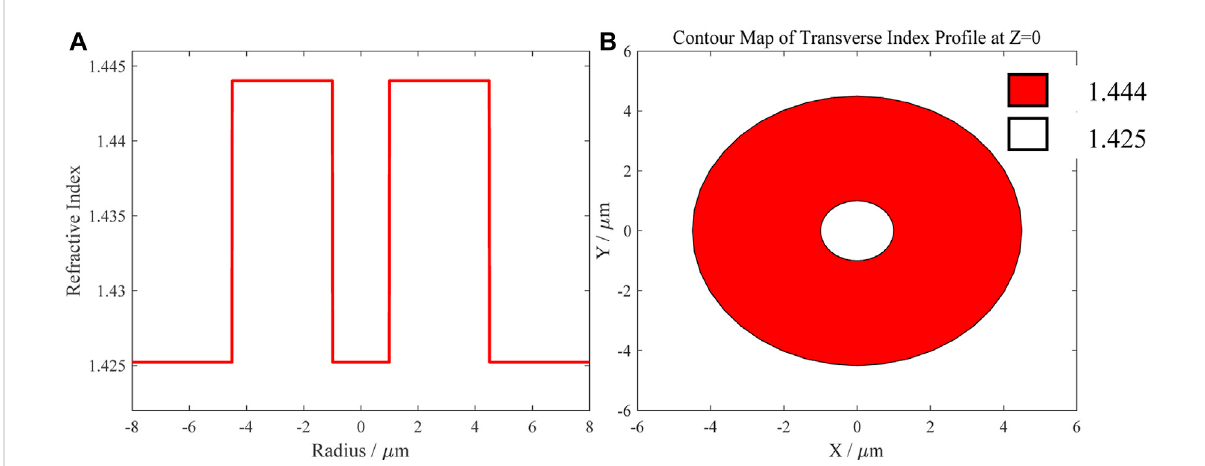
FIGURE 6 Refractive index distribution of FMF ring-core. (A) Refractive index distribution along the radial direction of the FMF ring-core. (B) Contour map of refractive index distribution along the cross-section of the FMF ring-core.